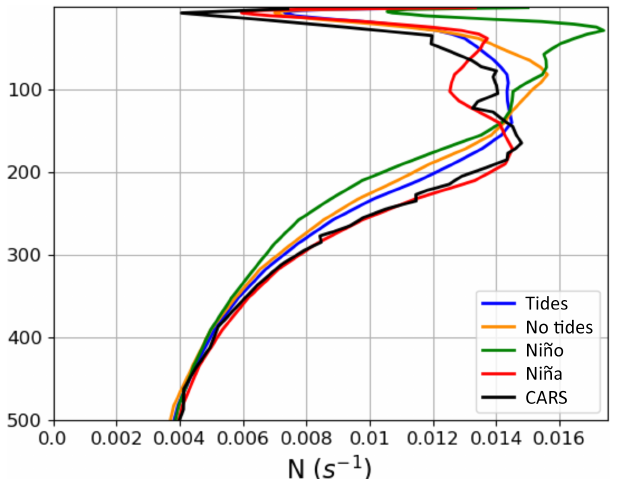
Figure 5. Mean N profile averaged for the Solomon Sea section at 154 ◦ E from CARS climatology (black) and from the R36Td TIDES simulation averaged over the entire 3-year period (blue), the 3-month El Niño period (green), and the 3-month La Niña period (red). The yellow line is for the R36d NOTIDES simulation aver- aged over the entire 3-year period. Units are in per second (s − 1 ).